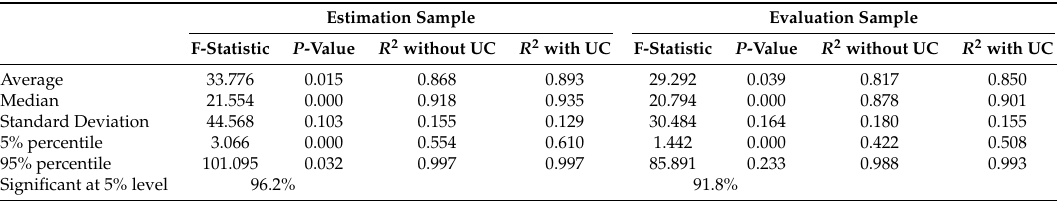
Table 10. A summary of results on the comparison between the regressions: of (1) Actual = α + β PC , the actual earnings on only predictable component variables; and (2) Actual = α + β PCV + γ UC , the actual earnings on both the predictable and unpredictable component variables. We performed these regressions for each firm separately (of the 316 firms) but pooled the results of all 18,338 forecasters. The total number of observations in the regressions across all firms is 146,319 in the estimation sample and 126,651 in the evaluation sample. The F-Statistic is based on the test for the joint significance of γ , the parameters of the unpredictable component variables, and the results for the associated P -value are shown in the column labeled P -value. The summarized results for the R 2 values for both the restricted and the unrestricted model are also